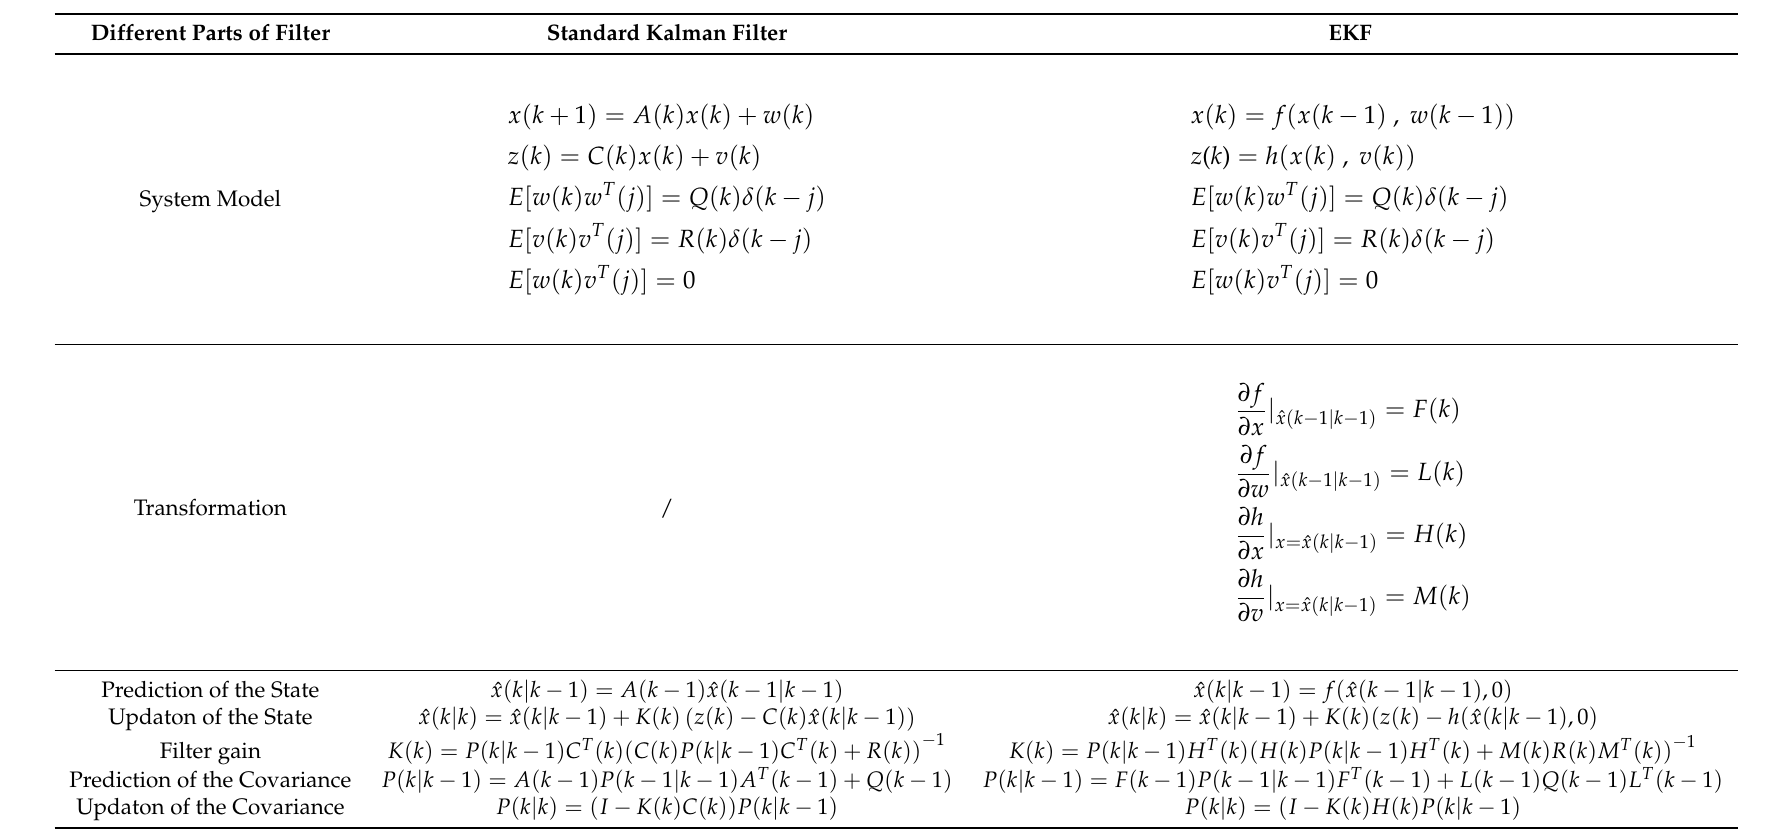
Table A1. The details of the Standard Kalman Filter and